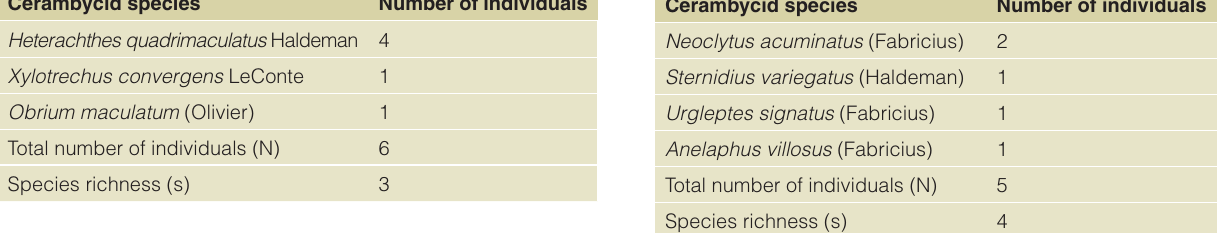
Table 6. Cerambycid Cerambycid (Coleoptera: Cerambycidae) Species Captured in Carter Woods, 2008 (Central Wood County, OH). Total number of individuals of each species caught during the entire trapping period (early June to early October). Traps were positioned in the approximate center of each forest and all checked each week.